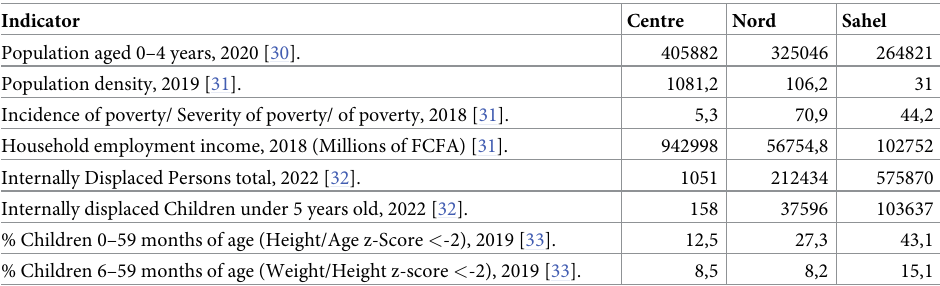
Table 1. Regional profiles. Indicator